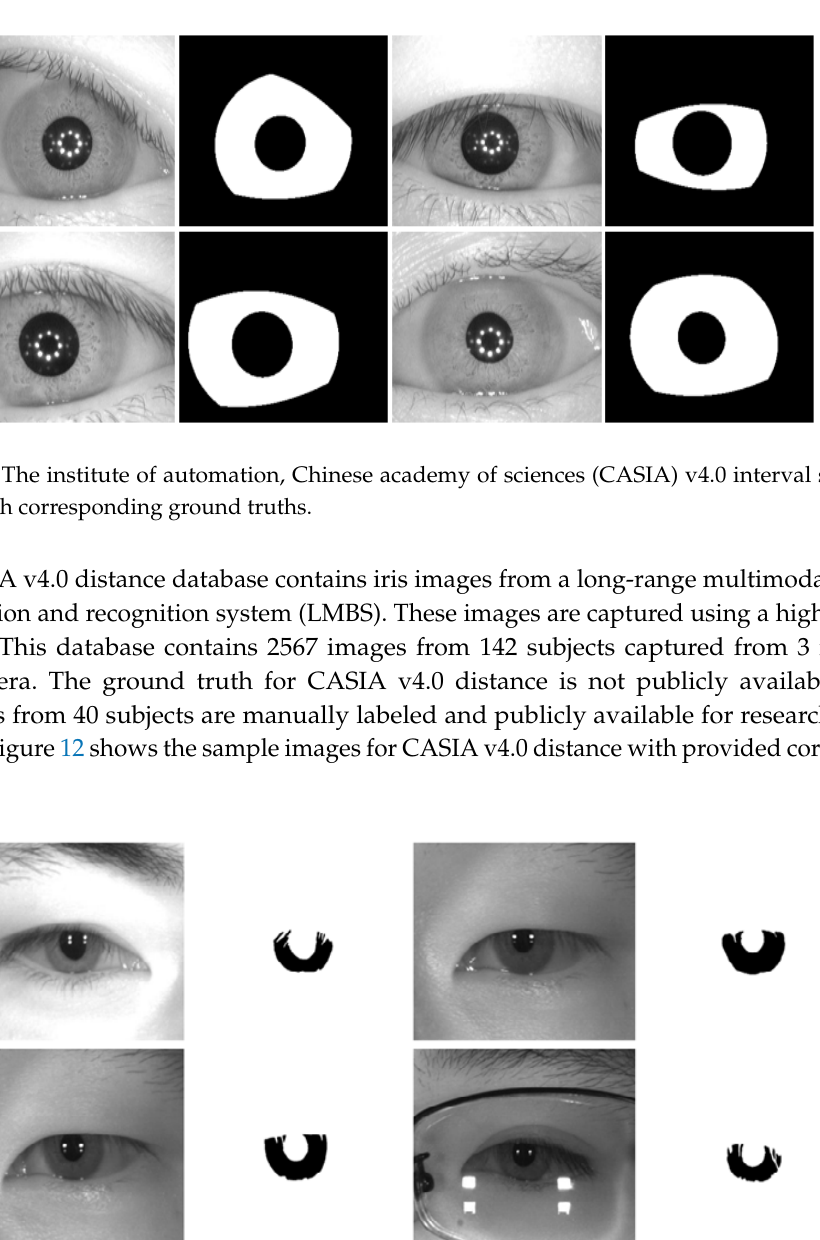
Figure 12. CASIA v4.0 distance sample images with corresponding ground truths.